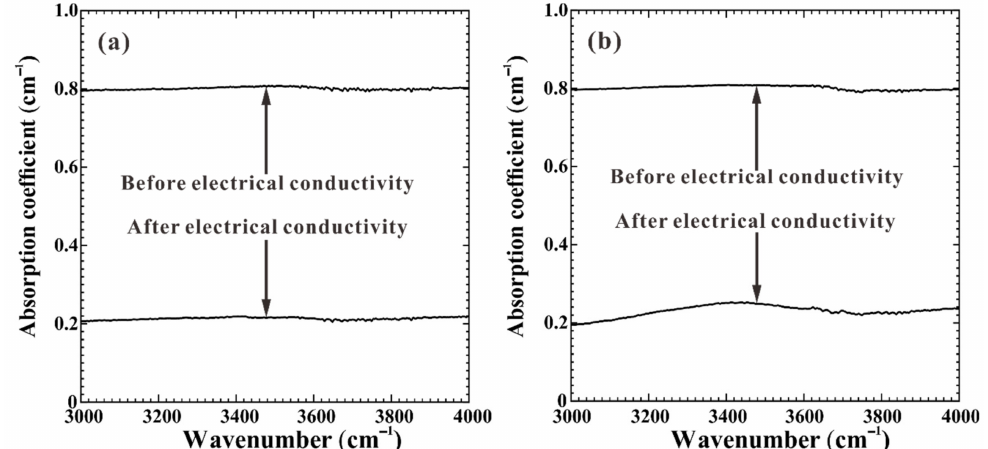
Figure 2. FT-IR spectra in the dry hot-pressed sintering gabbro before and after electrical conduc- tivity measurements within the wavenumber range of 3000–4000 cm − 1 . Here, ( a , b ) represent the clinopyroxene and plagioclase in the dry hot-pressed sintering gabbro,